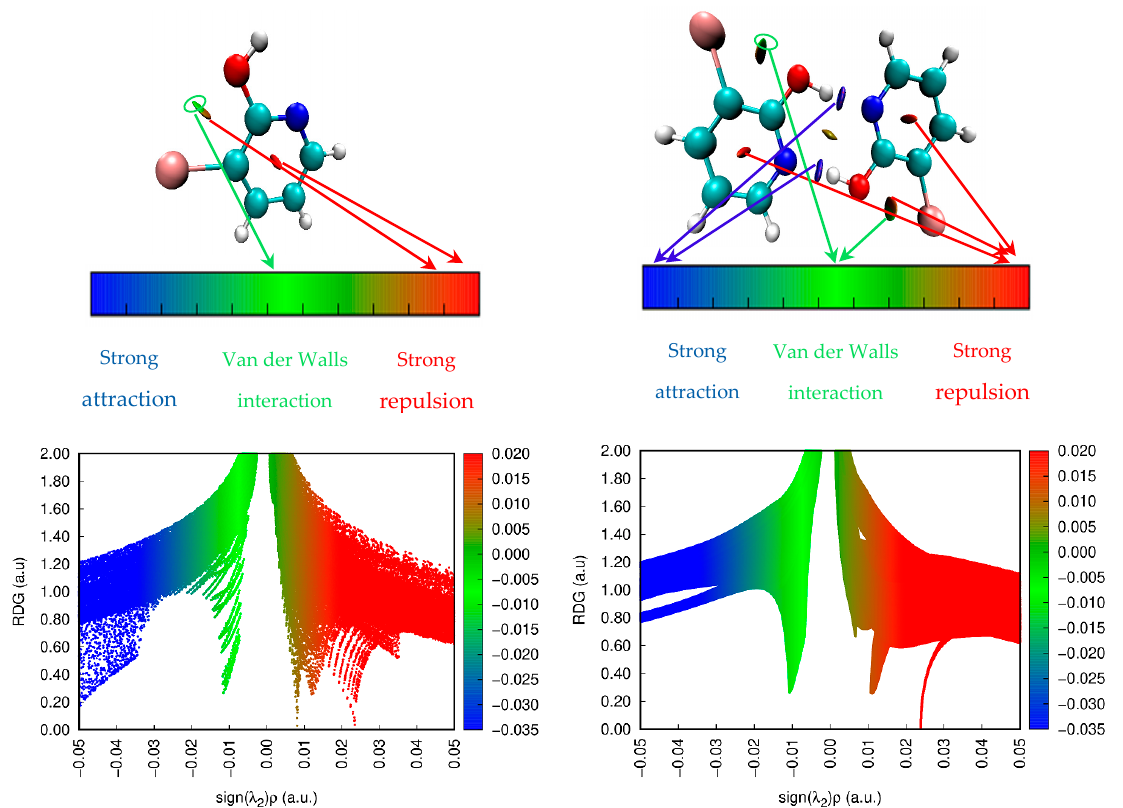
Figure 6. RDG function iso-surface with sign ( λ 2 ) ρ coloring scheme for crystalline structure of 3-Br-2-HyP molecule.